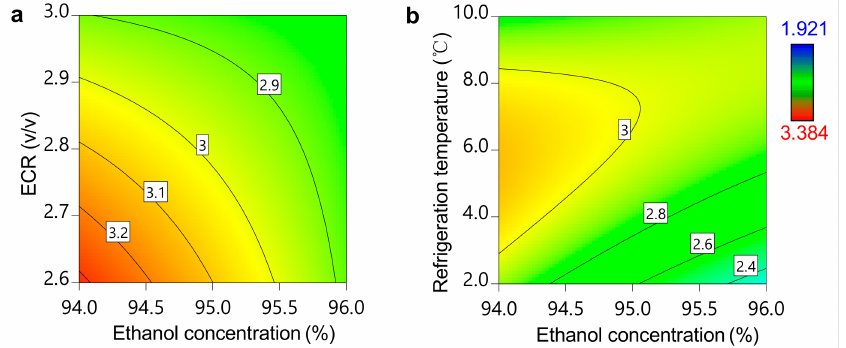
Figure 6. Contour plot of the extracted amount of total flavonoids. ( a ) Density of concentrated extract was 1.23 g/cm 3 , stirring time after ethanol addition was 90 min, refrigeration temperature was 6 ◦ C. ( b ) Density of concentrated extract was 1.23 g/cm 3 , ECR was 2.8 v / v , stirring time after ethanol addition was 90